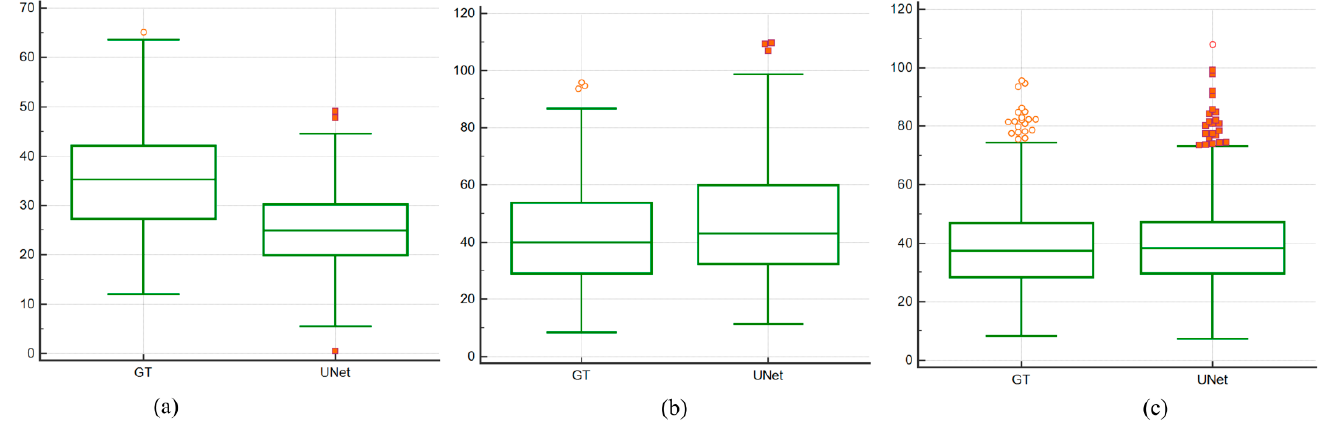
Figure 9. Comparison of paired t-test curves for Unseen AI and Seen AI database experiments. ( a ) Experiment #1 (Unseen AI-1 (Tr: JAP, Te: HK)) ( b ) experiment #2 (Unseen AI-2 (Tr: HK, Te: JAP)) ( c ) experiment #3 (Seen AI-1 CV w/ Mixed).